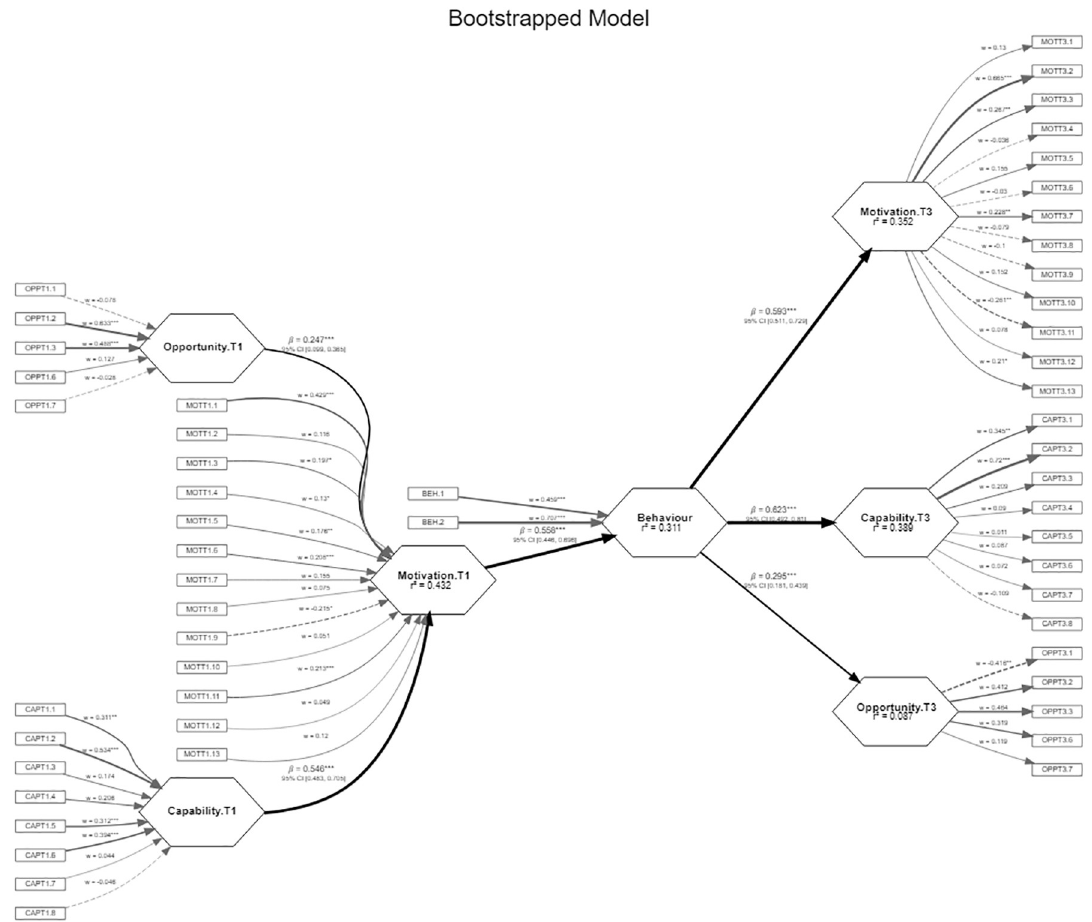
Fig 2. Initial model. The measurement model (rectangles) and the structural model (hexagons) are shown. Factor loadings for each indicator (w), standardized regression coefficients or path coefficients ( β ) with confidence intervals and coefficients of determination (R 2 ) are indicated. The greater the thickness of the arrow, the greater the loading or path